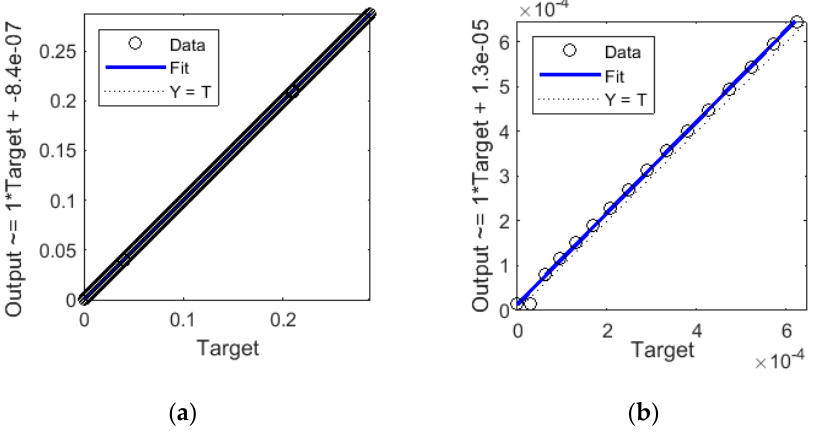
Figure 13. Regression statistics for closed-loop step-ahead NARX: ( a ) R ≈ 1 for whole set of 5980 cases, ( b ) R = 0.99946 for the subset of 16 cases.